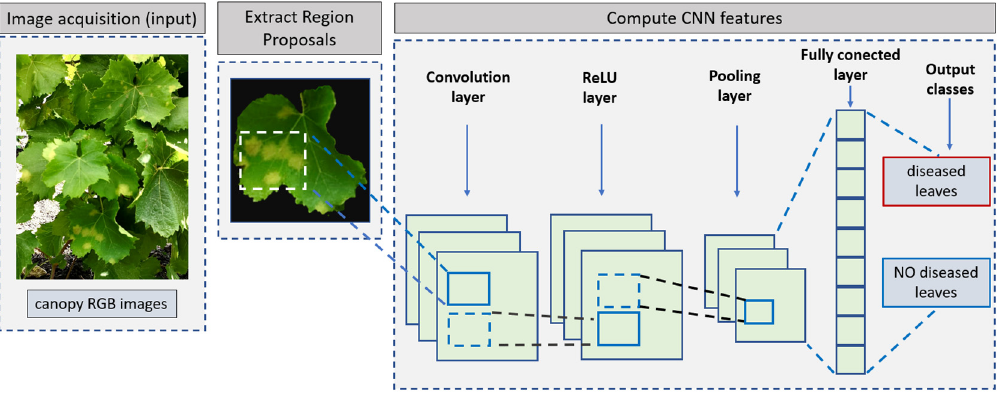
Figure 12. Structure of the segmentation method for diseased vine leaves applied using the R-CNN mask.